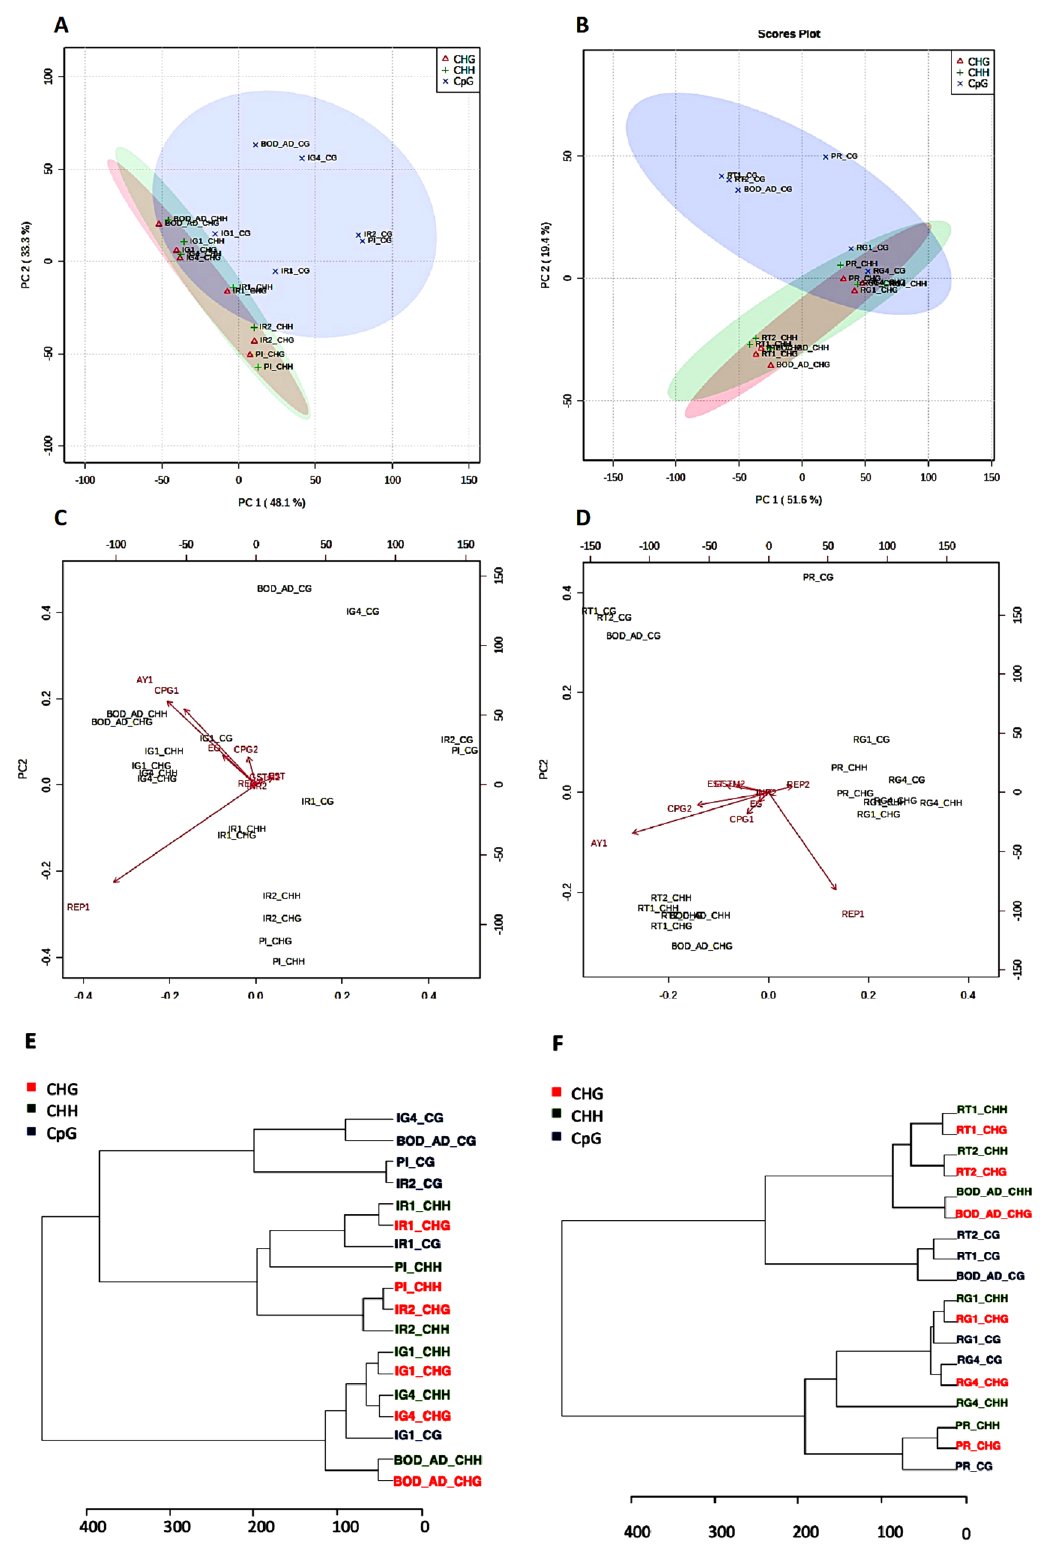
Figure 6. Assessment of the relationship between variables (methylation scores) across BPH populations (adults) exposed to stress and after its withdrawal. ( A ) Principal component analysis (PCA) plot showing distinct methylation patterns in CG and non-CG contexts for pesticide-exposed BPH populations. ( B ) PCA plots for BPH populations fed on RH. ( C ) PCA biplot representing the